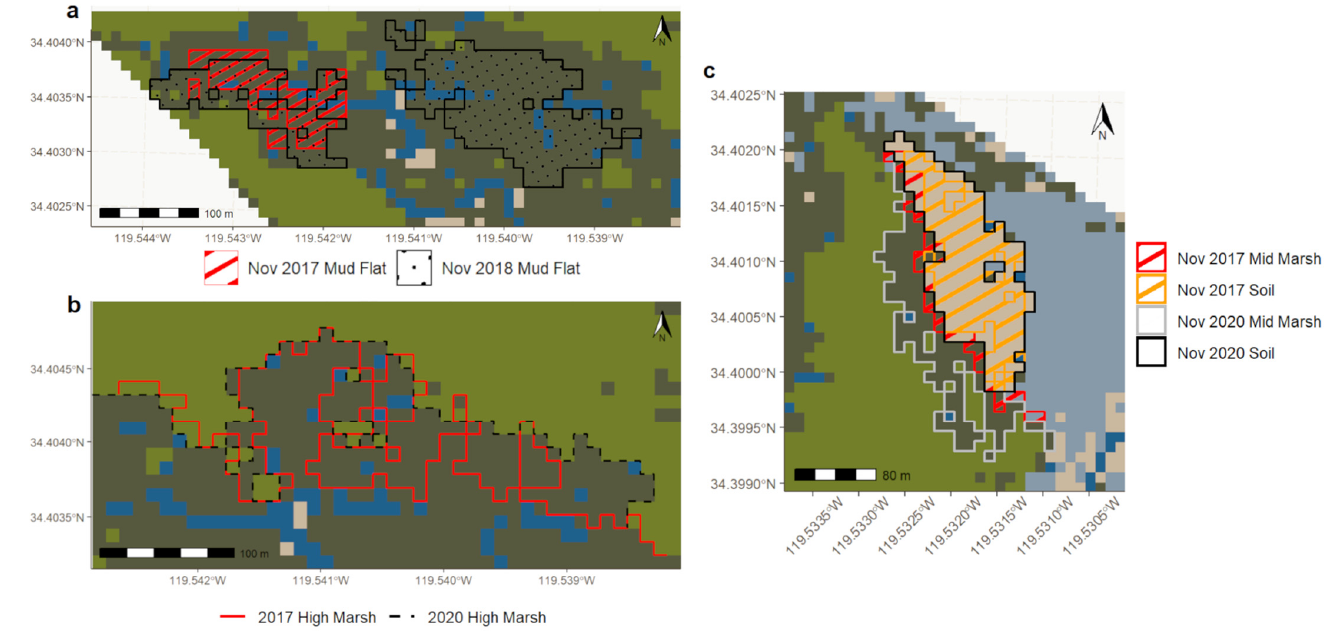
Figure 7. Maps highlighting areas where landcover change is most prominent. ( a ) High marsh to mid marsh conversion, ( b ) difference in mudflat extent, and ( c ) difference in salt pan (soil) and vegetated (mid marsh) perimeter. (Projection: NAD 84 UTM Zone 11, converted to lat/long).